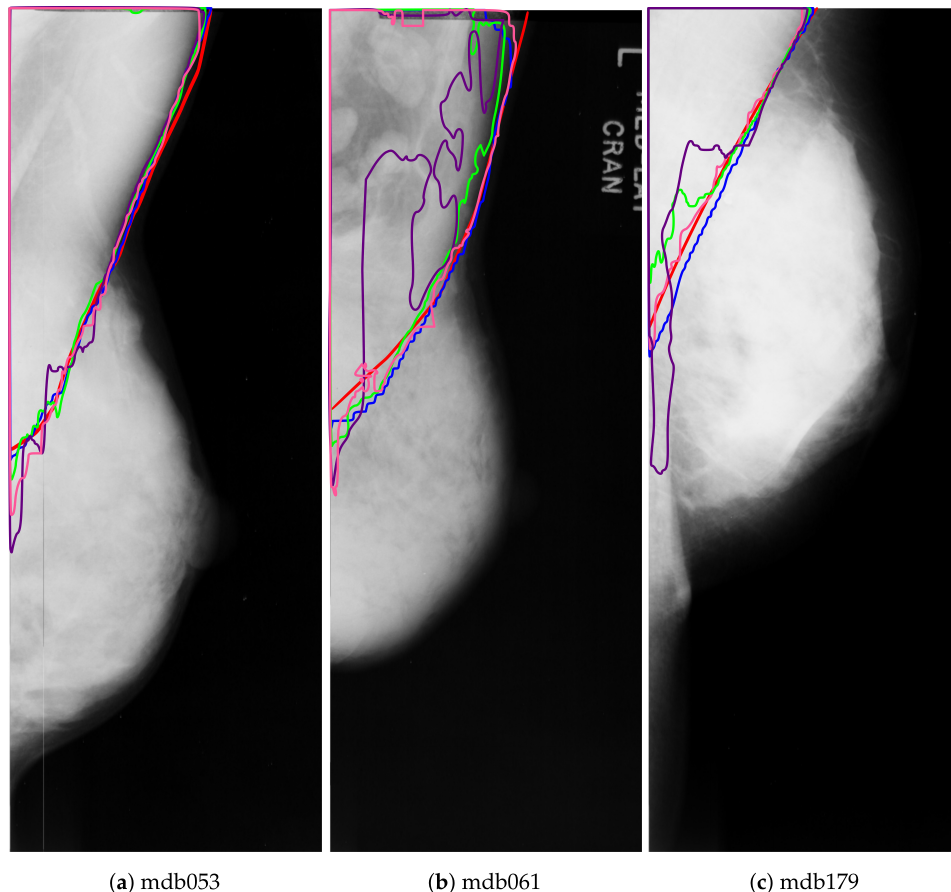
Figure 15. Pectoral muscle segmentation for the different DNNs: ground truth (red), ResNet50+PSPNet (blue), ResNet50+U-Net (green), VGG+FCN8 (pink), and VGG+U-Net